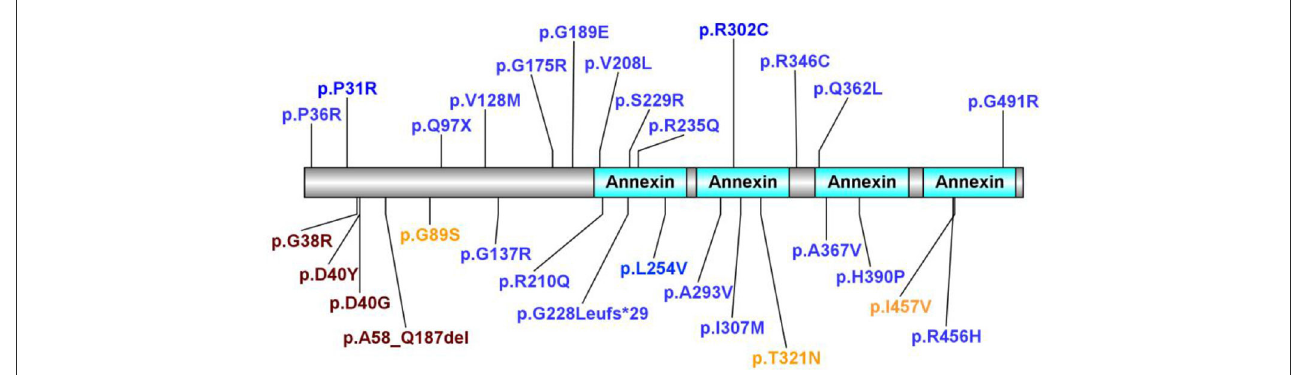
FIGURE3 In total, 29 ANXA11 variants identified. In total, four variants considered to be pathogenic or likely pathogenic are marked in purple. Variants considered to be benign or likely benign are marked in orange. Variants of uncertain significance are marked in